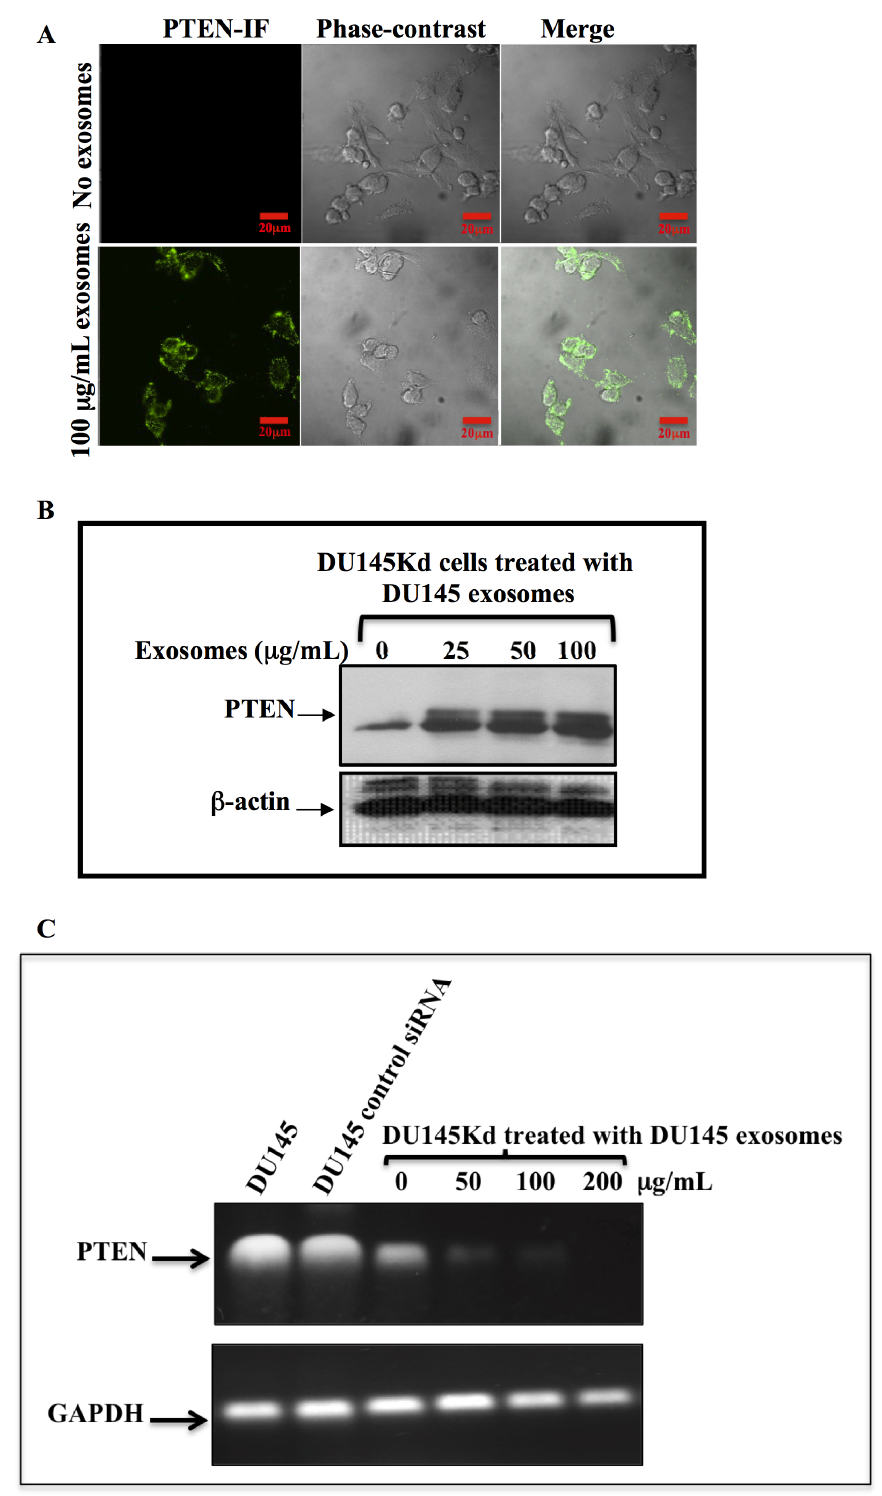
Figure 2. Exosomes transfer PTEN between prostate cancer cells. DU145Kd cells were incubated with different concentrations of exosomes derived from DU145 cells for 24 hours. A. DU145Kd cells were cultured in slide chambers and treated with DU145-derived exosomes. The cells were washed twice with phosphate buffered saline (PBS), and immunocytochemistry was performed with PTEN primary antibodies and Alexa fluor 488 secondary antibodies. The cells were visualized using confocal microscopy (IF- immunofluorescence). DU145Kd cells acquired PTEN (green) after incubation with Du145-derived exosomes. B. DU145Kd were cultured in 100-mm dishes and treated in the same manner as in (A) with different concentrations of DU145-derived exosomes. The cells were washed with PBS, lysed with RIPA lysis buffer, and analyzed for PTEN expression using immunobloting. DU145Kd cells acquired PTEN expression. C. Exosomes have an inhibitory effect on the transcription of PTEN. DU145Kd were treated